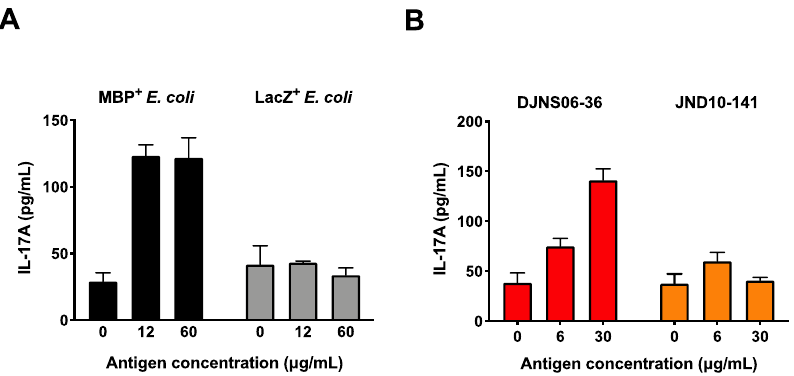
Figure 2. Production of IL-17A in MBP-specific Th17 cells in response to C. difficile DJNS06-36. MBP-specific Th17 cells were cultured with DR2a + DCs pulsed with cell extract of either ( A ) MBP + E. coli and LacZ + E.coli or ( B ) C. difficile DJNS06-36 and C. difficile JND10-141, and the production of IL-17A was examined. Data from one representative exper- iment of two independent experiments are presented.